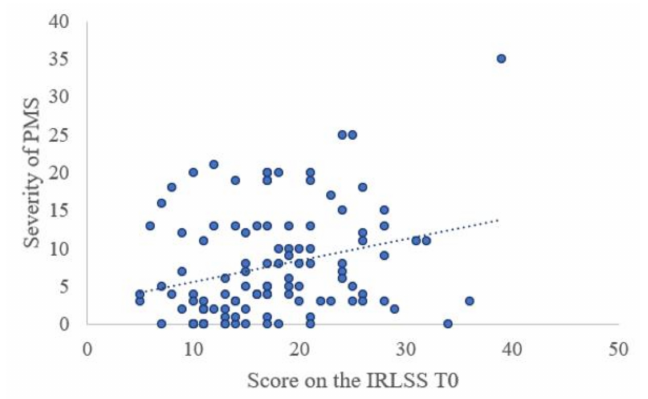
Figure 3. Correlation between IRLSS score at T0 and severity of PMS ( n = 109). PMS = Premenstrual Syndrome, T0 = 1 to 6 days after